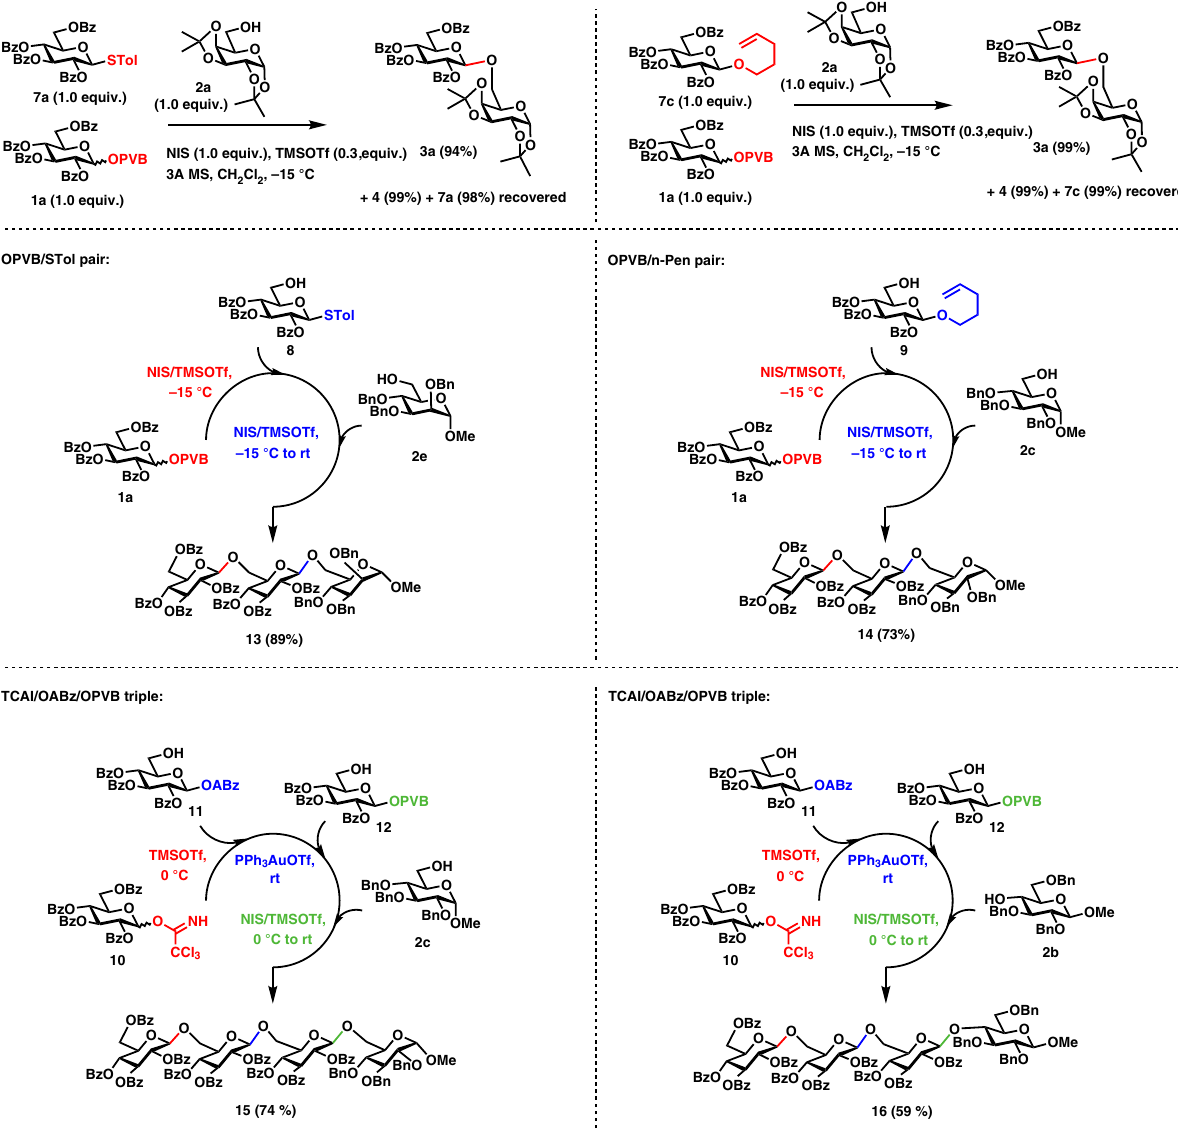
Fig. 4 Comparison of the donor reactivities and one-pot synthesis of oligosaccharides 13 – 16. Highlighted in red, blue, and green are the corresponding leaving groups, activation conditions, and glycosidic bonds formed. Tol p -tolyl, ABz ortho -alkynylbenzoates, PVB ortho -(1-phenylvinyl)benzoates, Pen pentenyl, TCAI